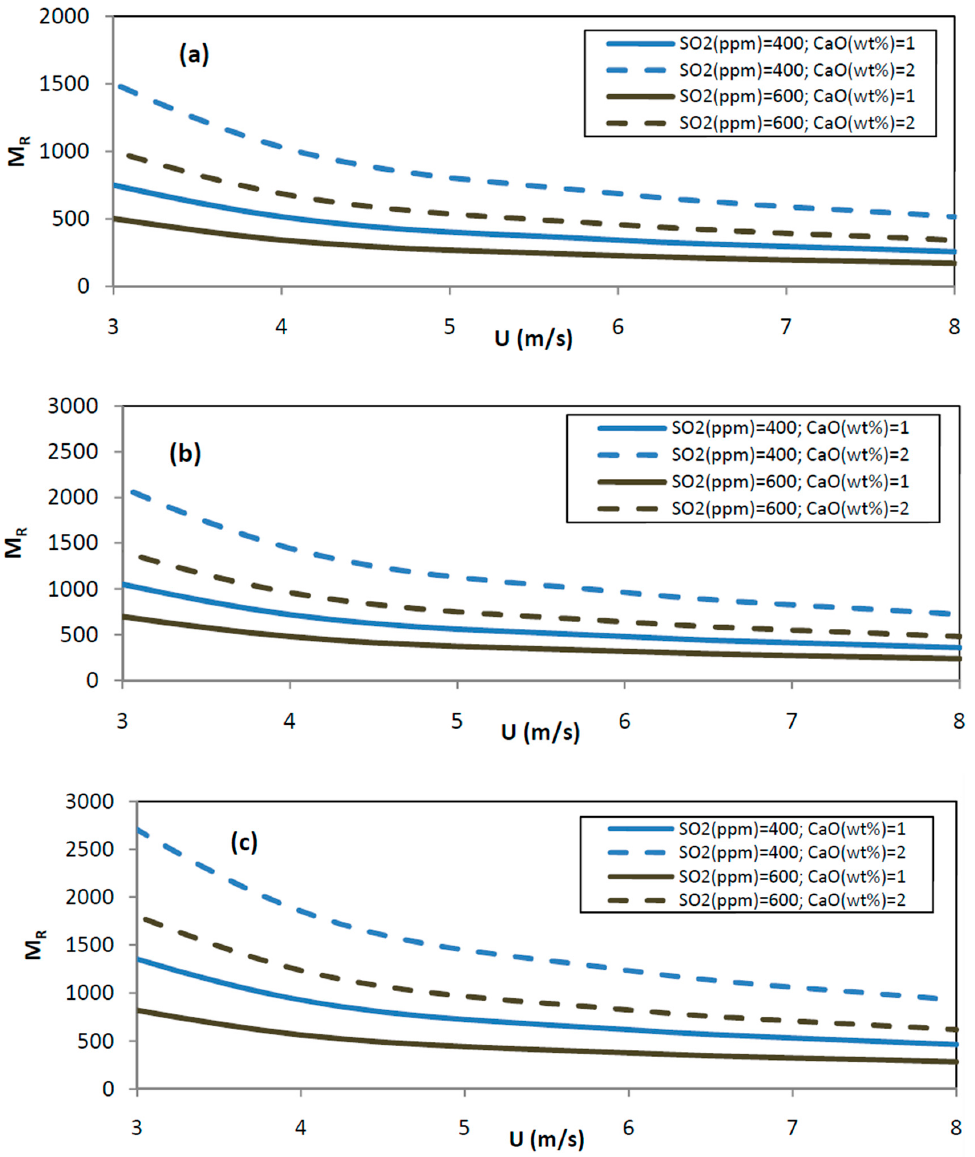
Figure 8. Molar ratio CaO/SO 2 at selected operating conditions (T = 1125 K) for G = 50 ( a ), 70 ( b ) and 90 ( c ) kg/m 2 s. The residence time distribution of the gas phase in the riser of a CFB was studied by [39]. The average contact time is given by: